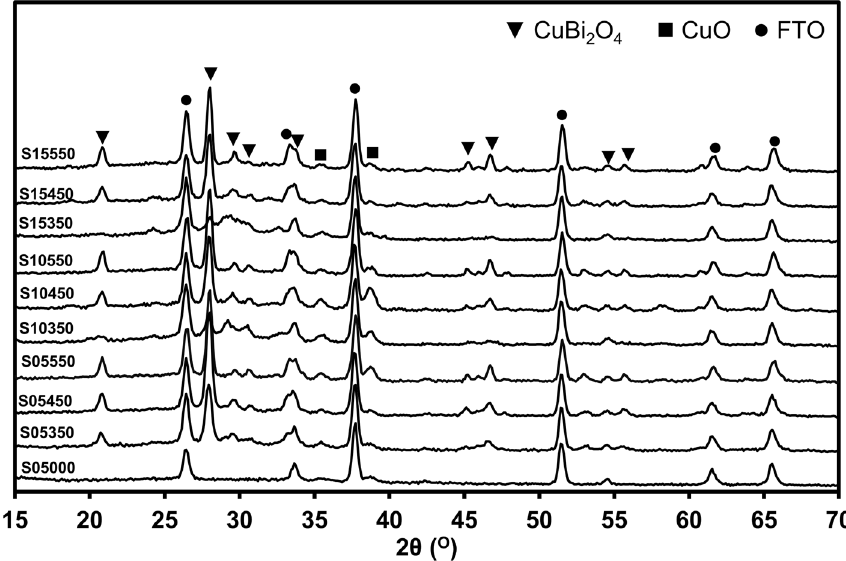
Figure 1. X-ray Difraction (XRD) spectra of FTO/CuO/CuBi 2 O 4 fabricated with different numbers of coating layer at different annealing temperatures. Triangular dots represent the peaks of CuBi 2 O 4 crystals based on JCPDS No.42.0334, and square dots represent the peaks of CuO crystals based on ICDD No#00-041-0254.